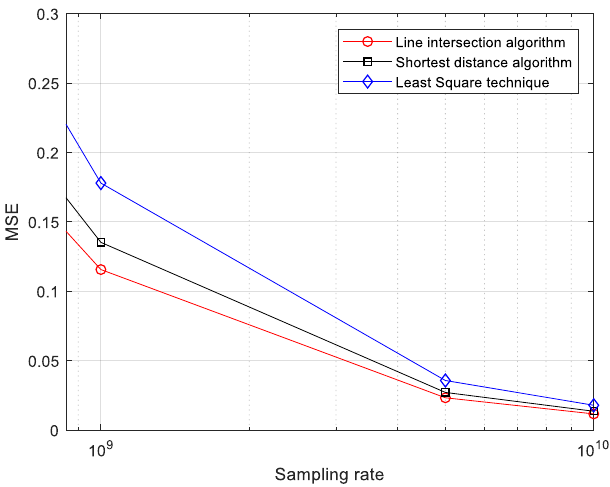
Figure 13. The enlarged MSEs of the MS position estimation for the second case.